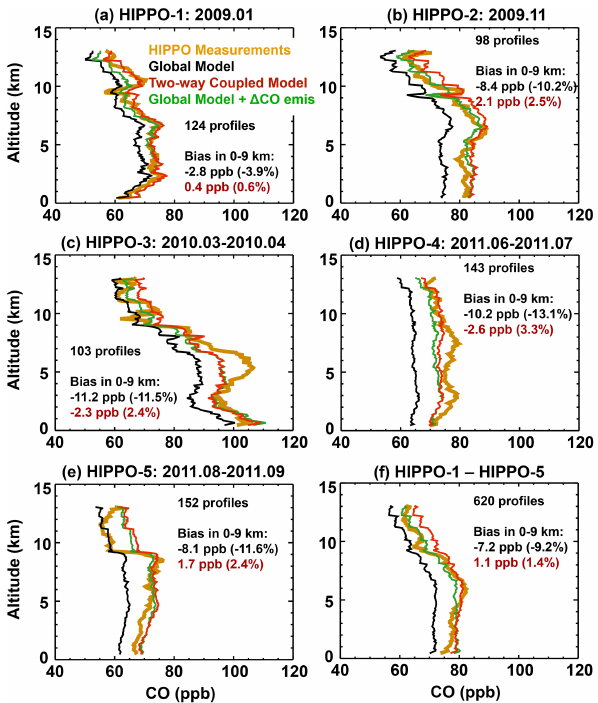
Figure 8. Measured and simulated vertical profiles of CO at 0.1km intervals averaged over (a–e) individual and (f) all HIPPO cam- paigns. Model results are sampled at times and locations coincident to HIPPO measurements. Green lines represent global model sim- ulations with increased global CO emissions that roughly resemble the two-way coupled simulation (especially below 4 km); increases in CO emissions are 15% for HIPPO-1, 25% for HIPPO-2, 15% for HIPPO-3, 25% for HIPPO-4, and 35% for HIPPO-5. Also shown are the number of profiles and mean model biases below 9km (with abundant measurements).